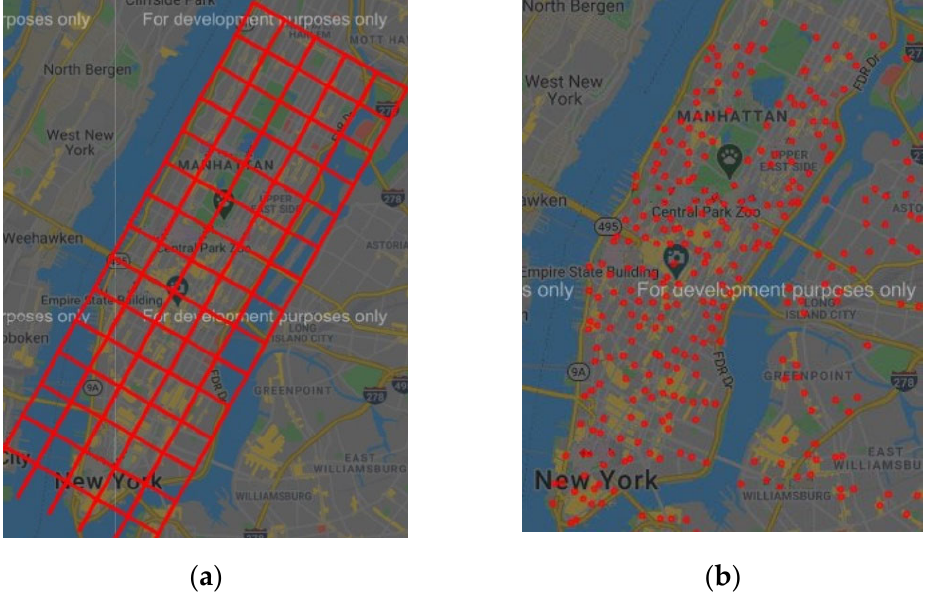
Figure 1. Two main approaches to processing traffic data. ( a ) Grid ‐ based approach. ( b ) Station ‐ based approach.